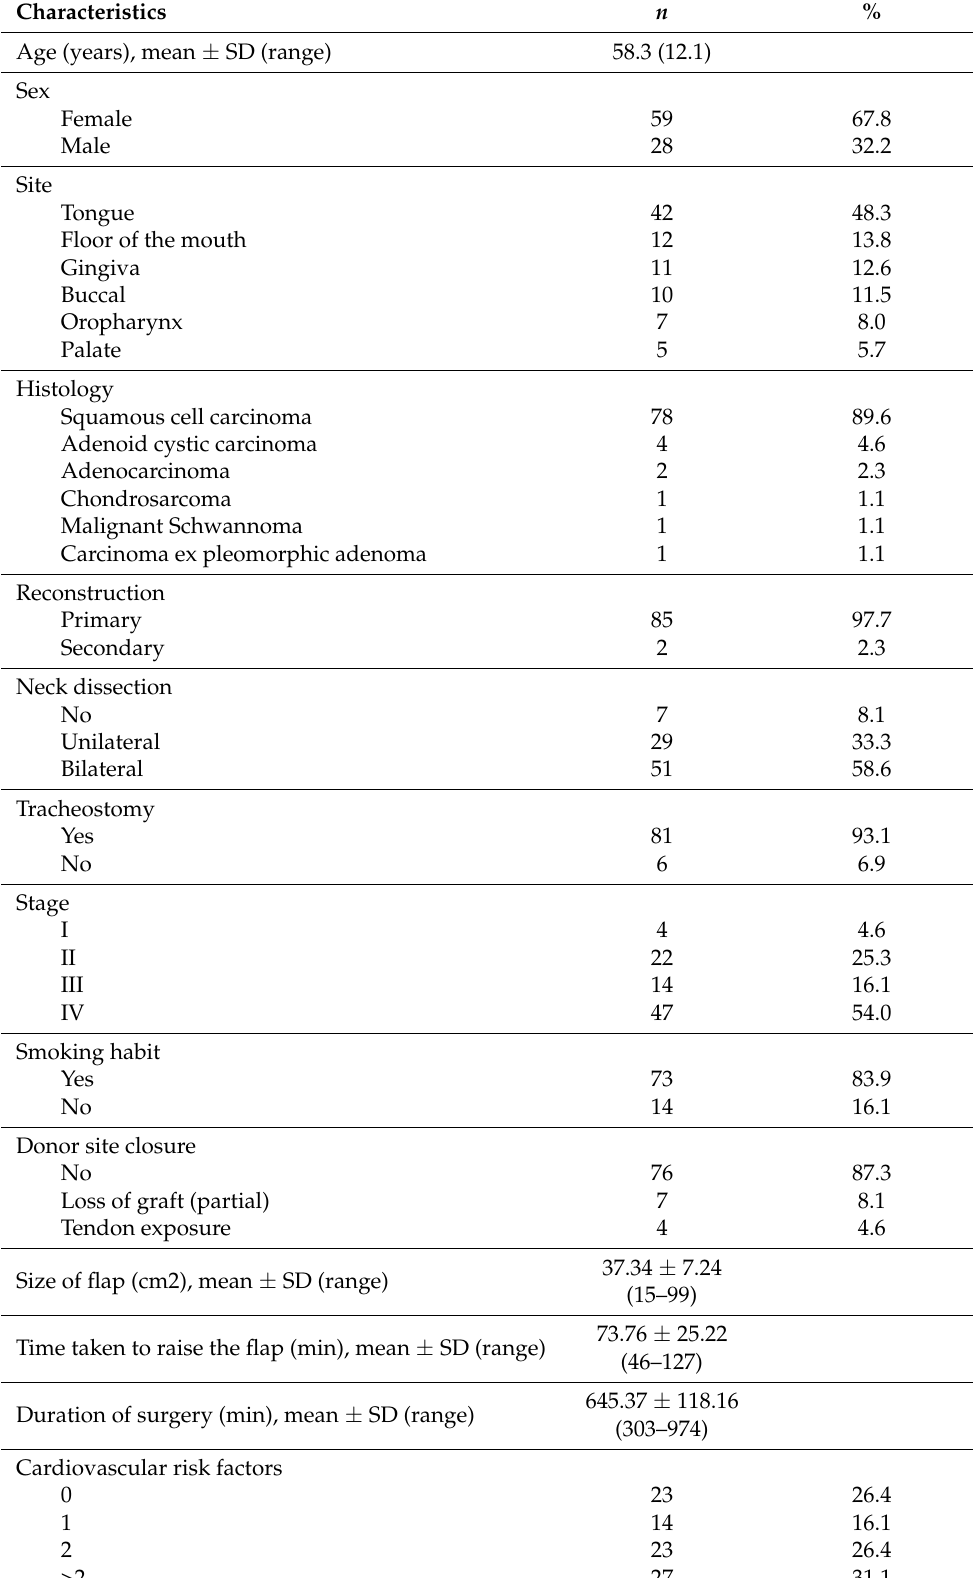
Table 1. Baseline characteristics of 88